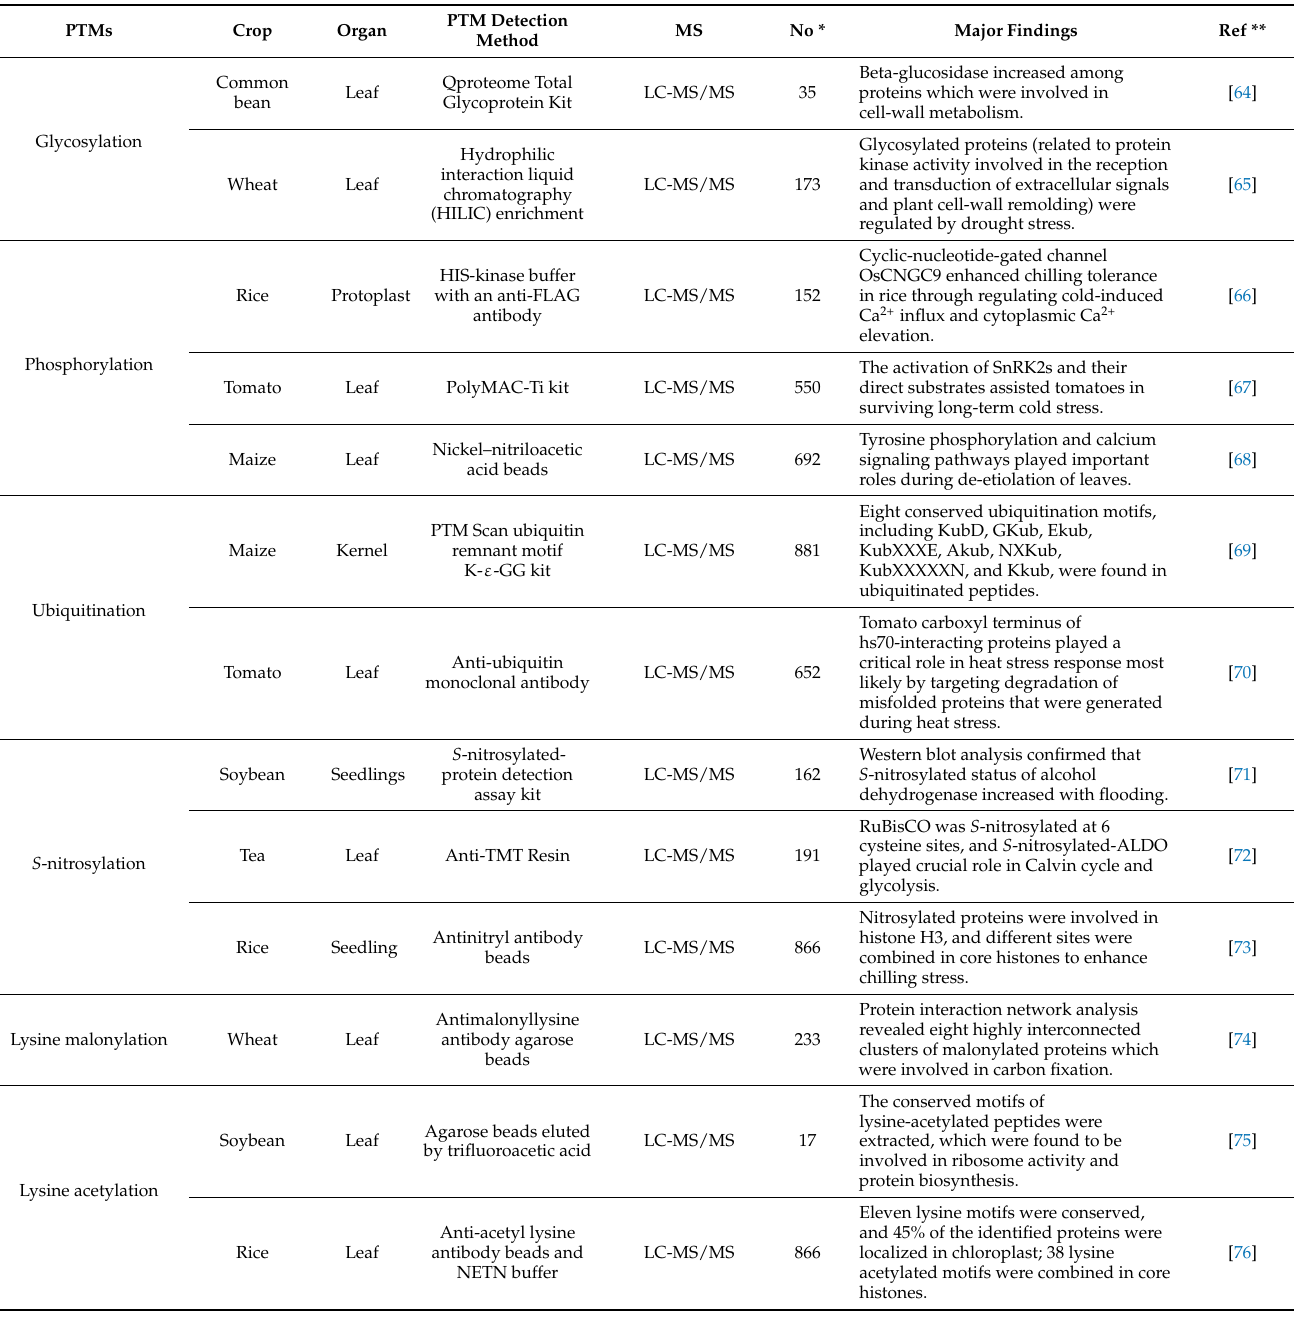
Table 3. PTM proteomics in crops during